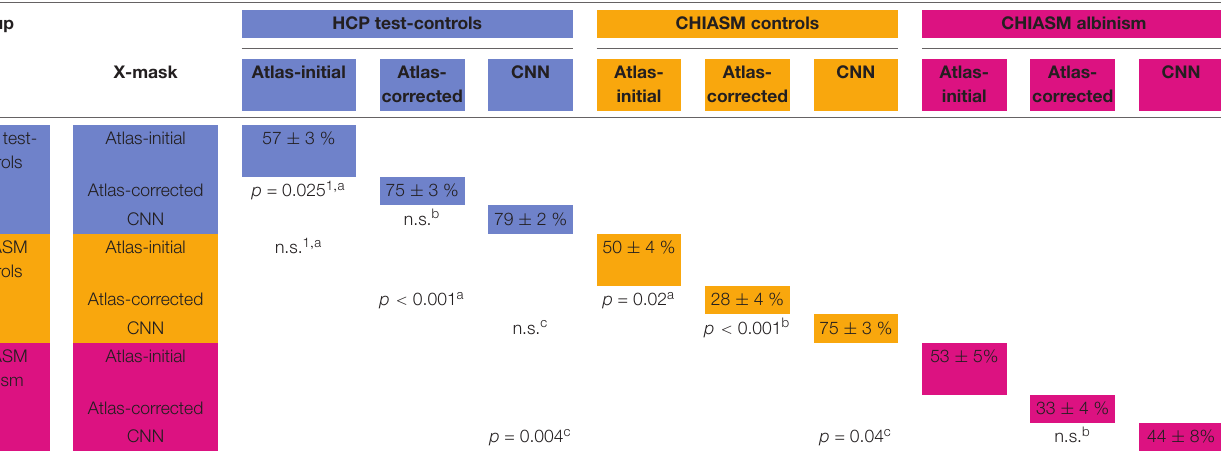
TABLE 1 | Mean and standard error of mean of DSC of X-mask and significance of cross-group differences.